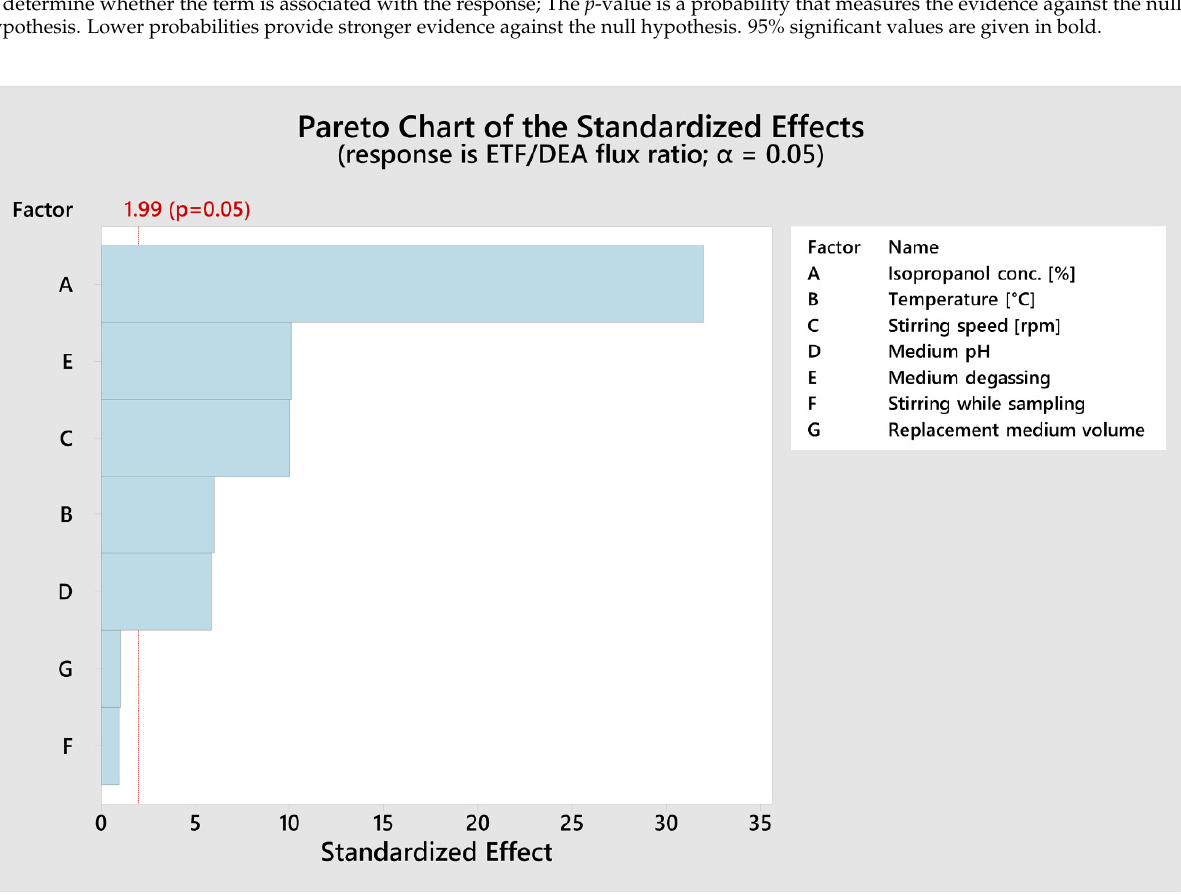
Figure 2. Response surface (3-D) plot illustrating the effect of isopropanol concentration and medium degassing on ETF/DEA flux ratio values.